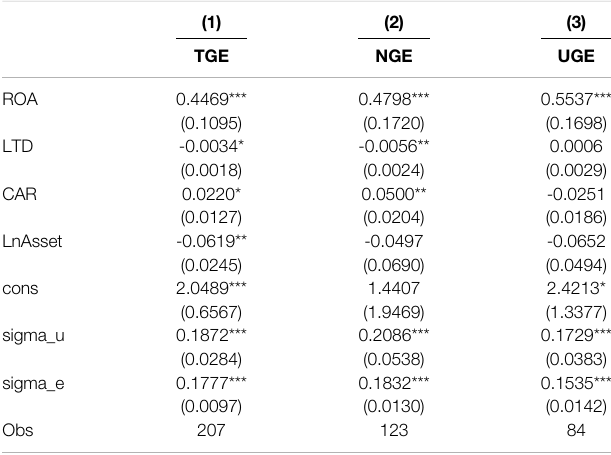
TABLE 8 | In fl uencing factors of green credit ef fi ciency in Chinese commercial banks.